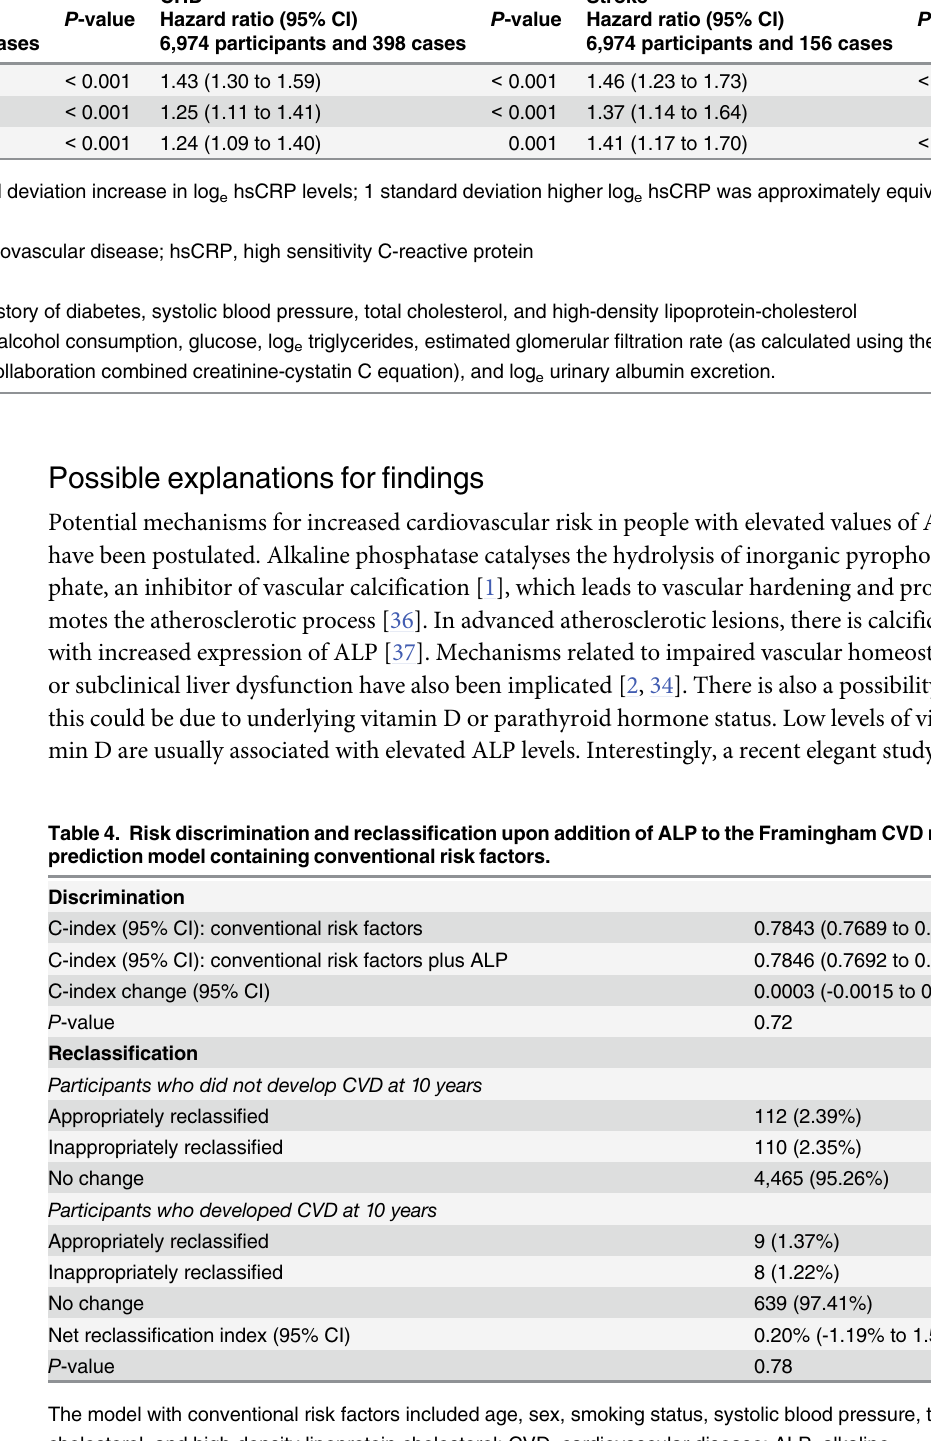
Table 3. Associations of hsCRP with incident CVD, CHD and Stroke. Models